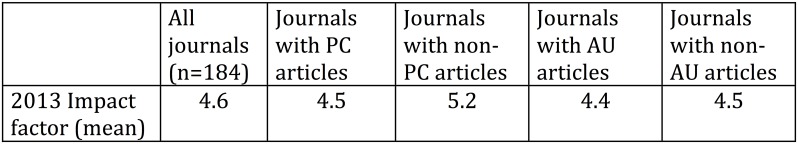
Impact Factors of Journals.Impact factors of journals with Publication-complete (PC), publication non-complete (non-PC), Analgesia Use (AU), and Analgesia non-Use (non-AU), in both the pre-2011 and the 2014–15 periods.